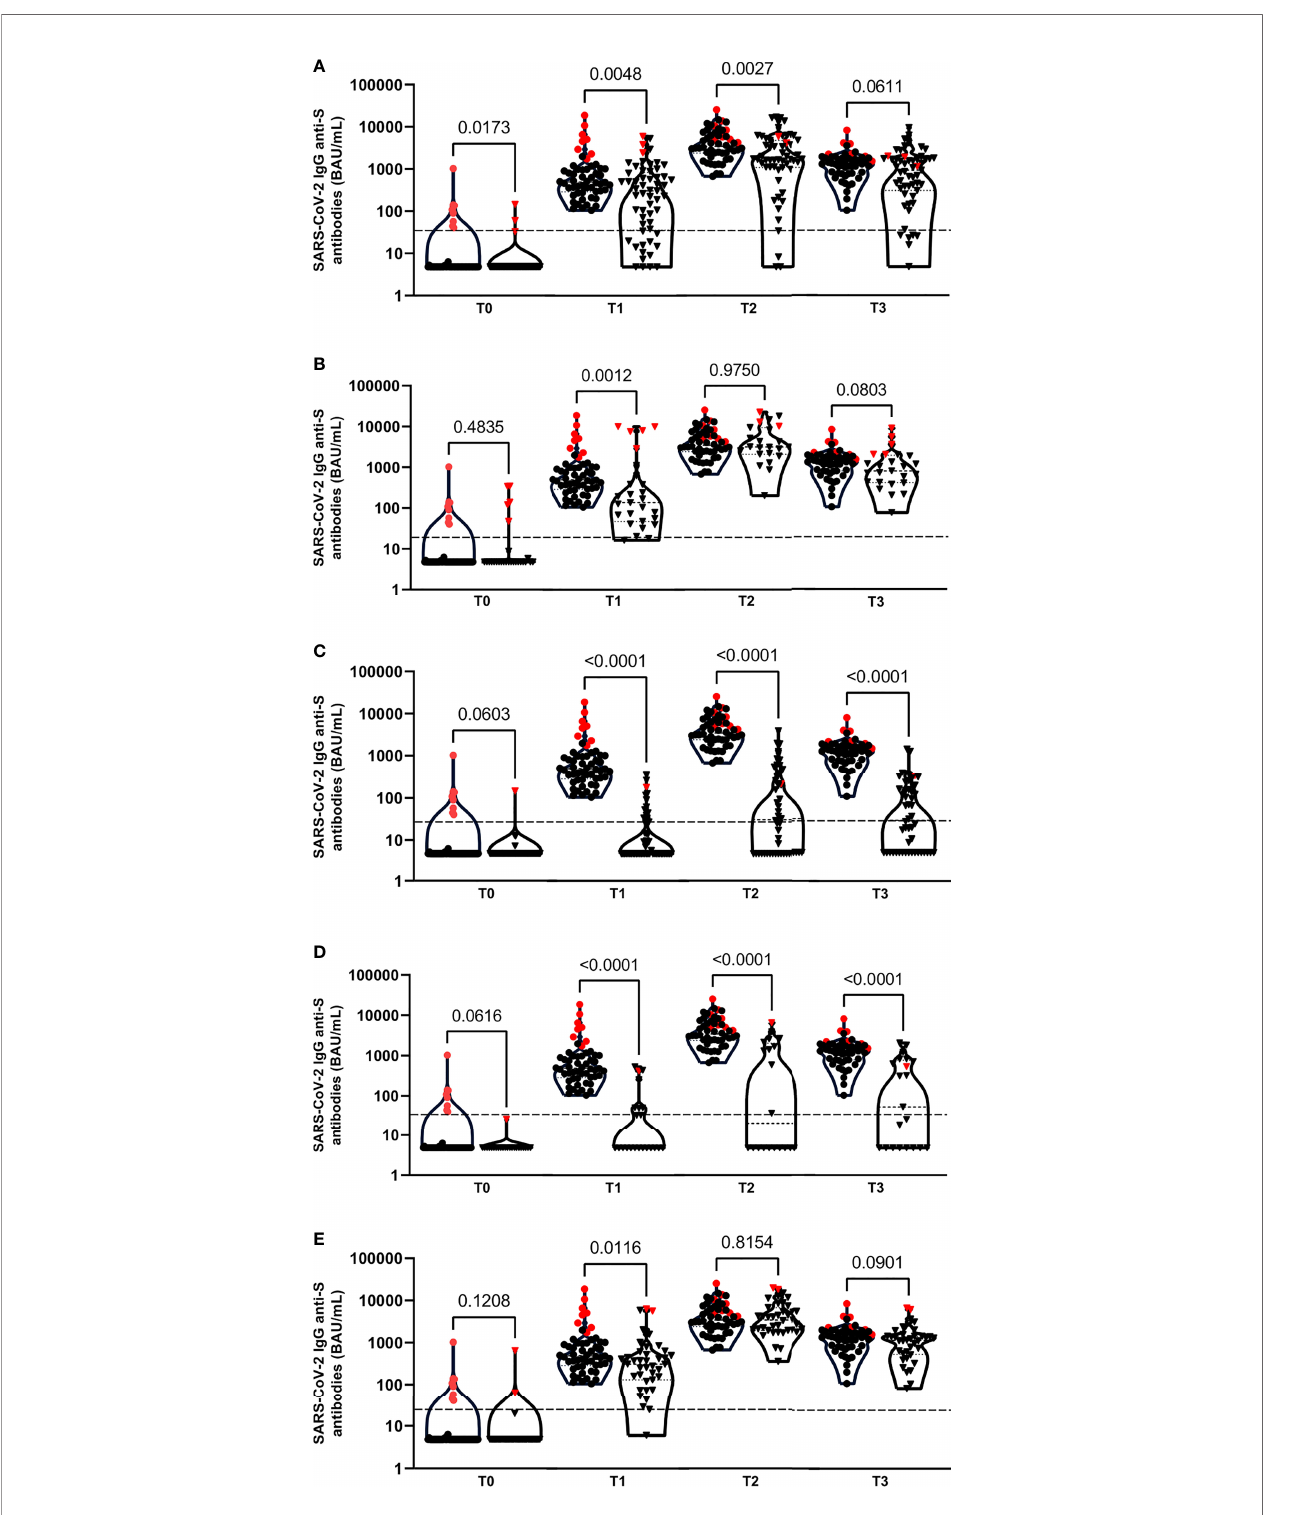
FIGURE 1 | Violin plots of anti-SARS-CoV-2 IgG antibodies at T0, T1, T2 and T3 time points between the healthy control group ( ● ) and patient groups ( ▼ ): primary immunode fi ciency patient group (A) , PLWH (B) , neurologic (C) , rheumatologic (D) and CKD (E) patient groups. Patients with a documented Sars-CoV-2 infection are indicated with red symbols. Each plot represent the median, 25th and 75th percentiles. Outliers were determined by 1.5 time IQR. Statistical signi fi cance was calculated by Mann-Whitney U test. Signi fi cance was de fi ned as a p-value < 0.05.